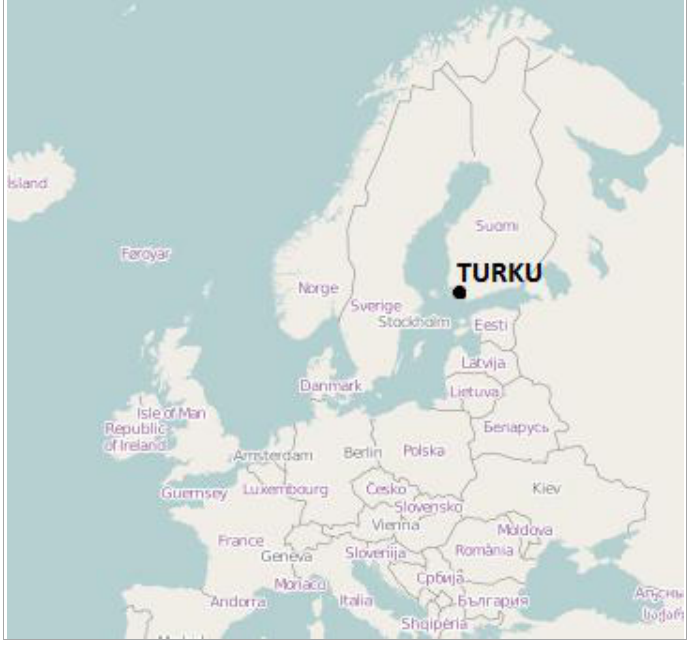
Figure 2. An example cross-section of the soil types in the area. Modified from